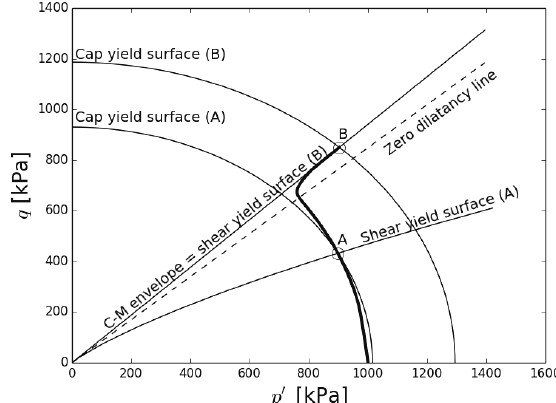
Fig. 1. Evolution of the effective stress path in the undrained triaxial test assuming uncoupled shear/volumetric plastic mechanisms (OCR =